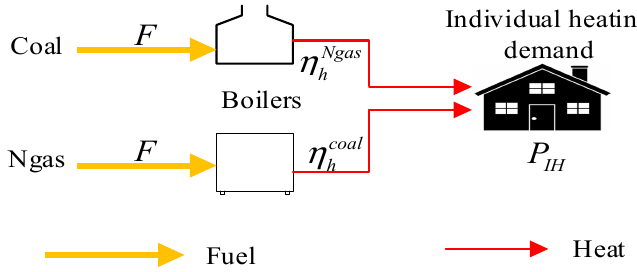
Figure 7. Coal and Ngas boilers are used to meet base case individual heating demand.